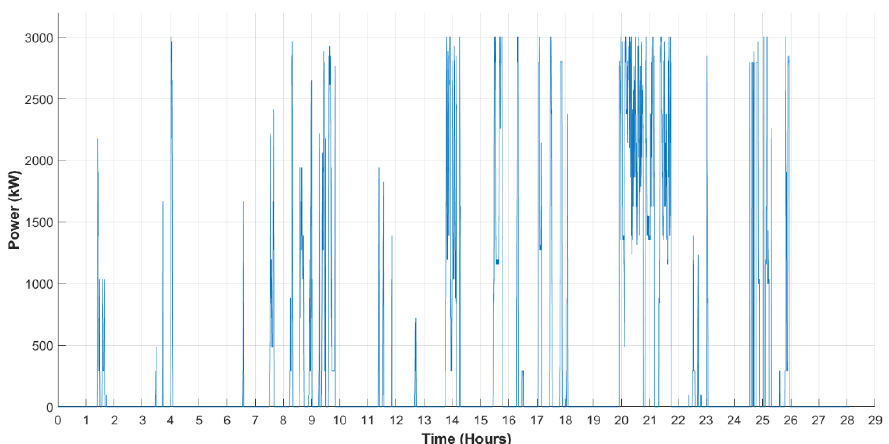
Figure 9. Recovered power (considering storage limits).